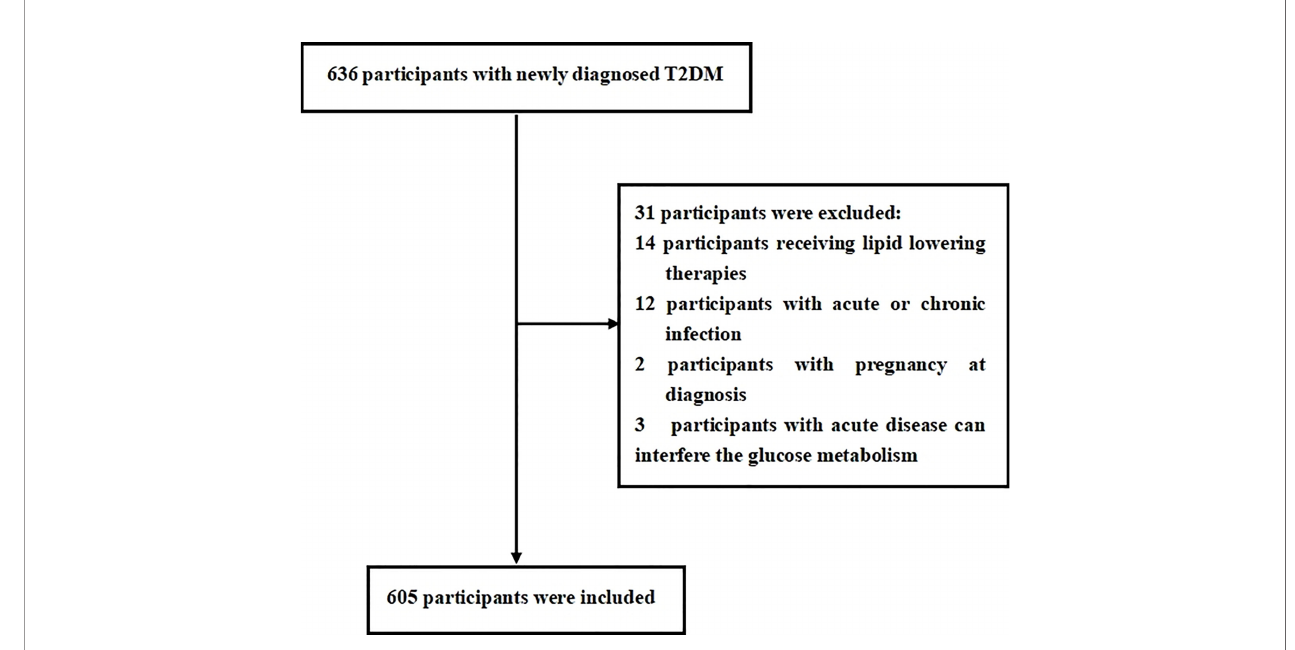
FIGURE 1 | Flow diagram of the participants excluded and included in this